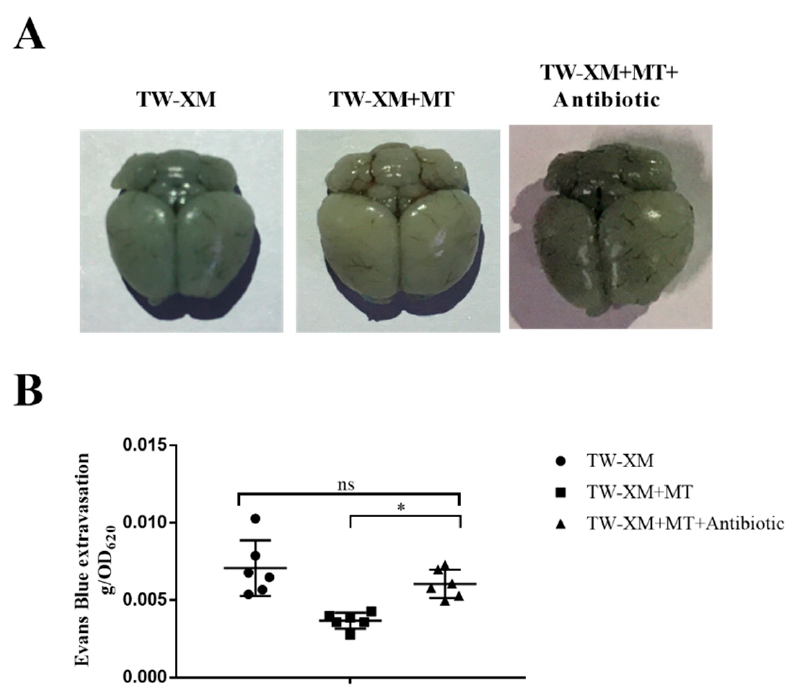
Figure 6. In the absence of intestinal microbiota, melatonin failed to protect the BBB integrity in APEC TW − XM − infected mice. ( A , B ) The BBB integrity, analyzed qualitatively and quantitatively by Evans blue infiltration assay. All data were determined by one − way ANOVA and expressed as means ± SEM. * p < 0.05, ns p > 0.05.